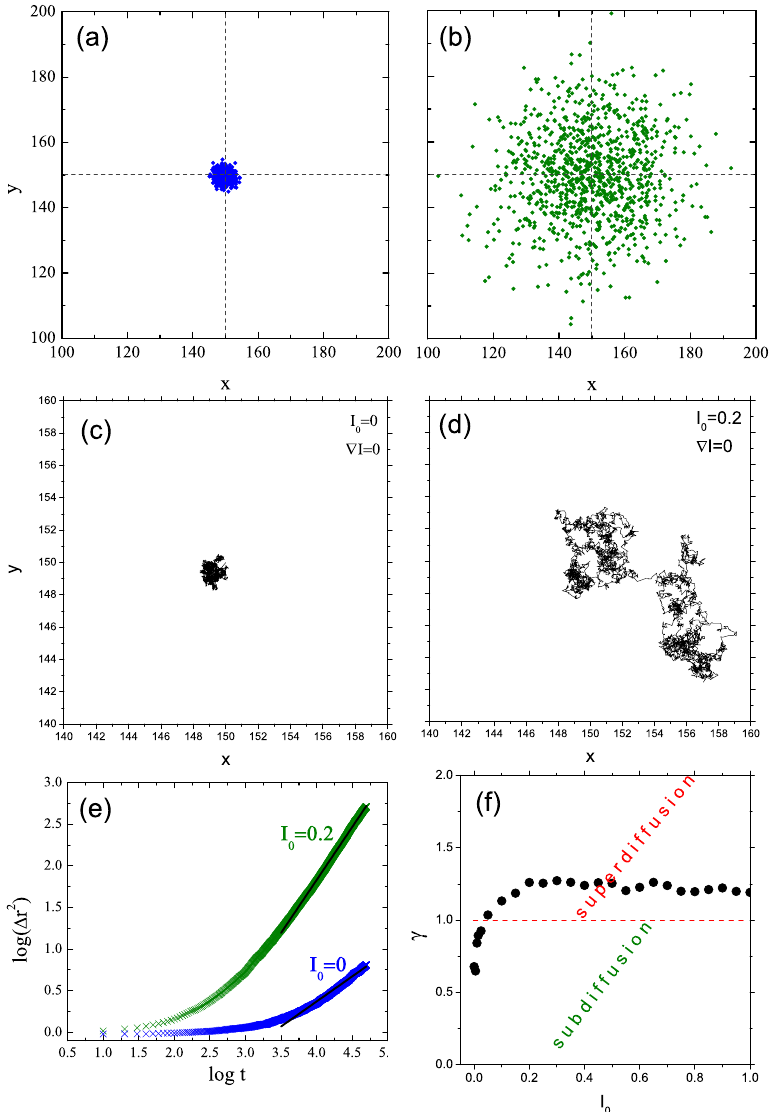
Figure 5. Projection of CM of 10 3 chains onto x − y plane for I 0 = 0.0 ( a ) and 0.2 ( b ) at the end of the simulation for homogeneous illumination ( ∇ I = 0). Projection of a typical trajectory onto x − y plane for I 0 = 0.0 ( c ) and 0.2 ( d ). Log-log plot of ( ∆ r ) 2 ( t ) for I 0 = 0.0 and 0.2 ( e ). Plot of exponent γ as function of intensity I 0 for homogeneous illumination ( f